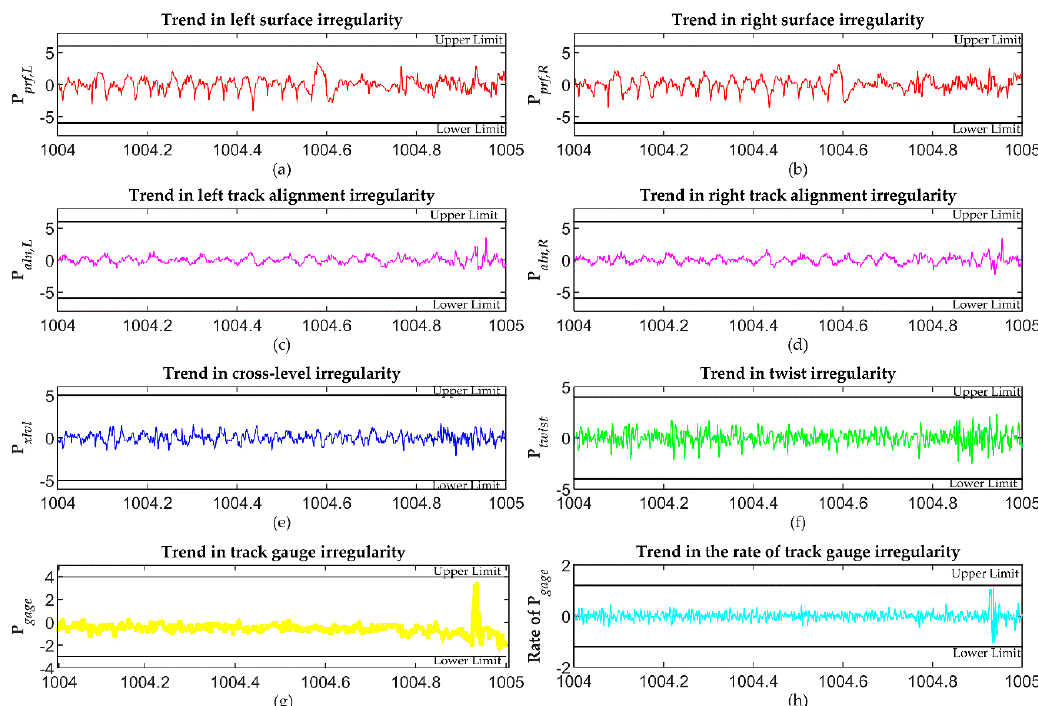
Figure 4. Trends in the geometric parameters from K1004 to K1005 (unit: km): ( a ) Left surface irregularity, ( b ) right surface irregularity, ( c ) left track alignment irregularity, ( d ) right track alignment irregularity, ( e ) cross-level irregularity, ( f ) twist irregularity, ( g ) track gauge irregularity, and ( h ) the rate of track gauge irregularity.